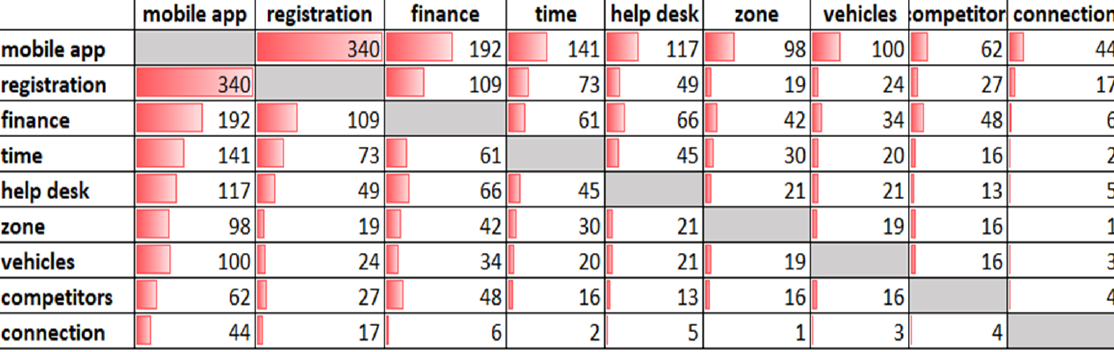
Table 5. Statistics on the companies’ responses to users’